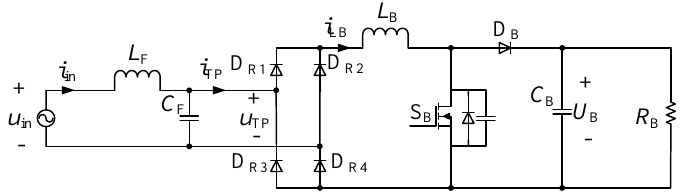
Figure 3. Equivalent circuit of the SSC with LC filter.